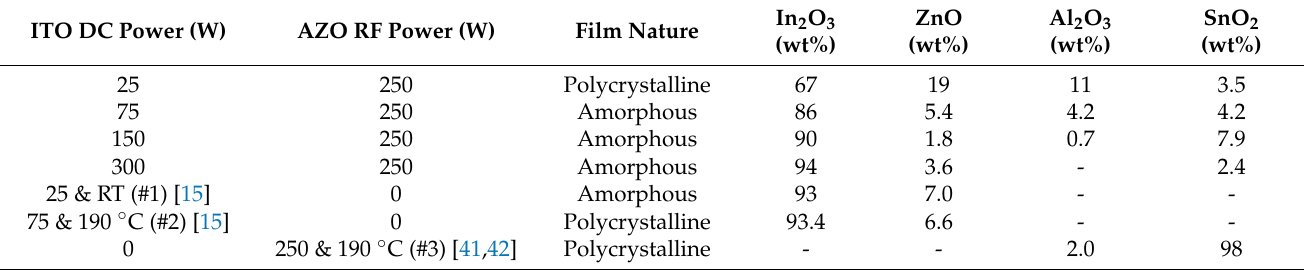
Table 5. Compound’s concentrations estimated by WD-XRF. The film nature is